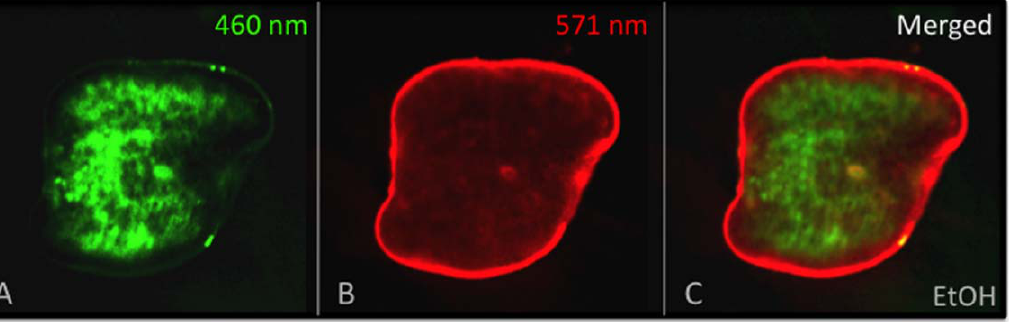
Figure 8. EtOH Immobilization is an Improved Method for Reporter Dye Assays. Membrane Voltage Reporter Dye Assay . When consecutive images of a single planarian trunk fragment at 24 hours of regeneration, showing ( A ) CC2 (460 nm) and ( B ) DiBAC (517 nm) staining, are ( C ) overlaid, the EtOH-mediated fine movement inhibition results in images that merge completely in register, allowing for the DiBAC correction of CC2 fluorescence required by the assay. Compare this overlay with the failed overlay using PC2-RNAi in Figure 1A. Regenerates were treated with 3% EtOH just prior to reporter dye incubation and imaging. Anterior is to the right.